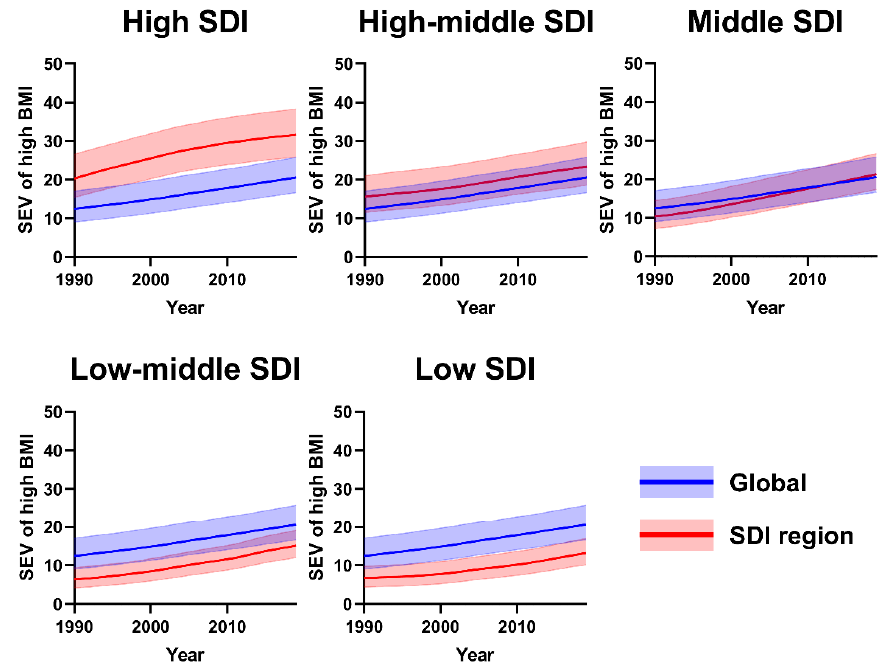
Figure 7. SEV of high BMI for women (per 100) in global and SDI regions from 1990 to 2019. Red represents SDI regions, and blue represents global levels. SEV, Summary exposure values; SDI, Socio-demographic Index.